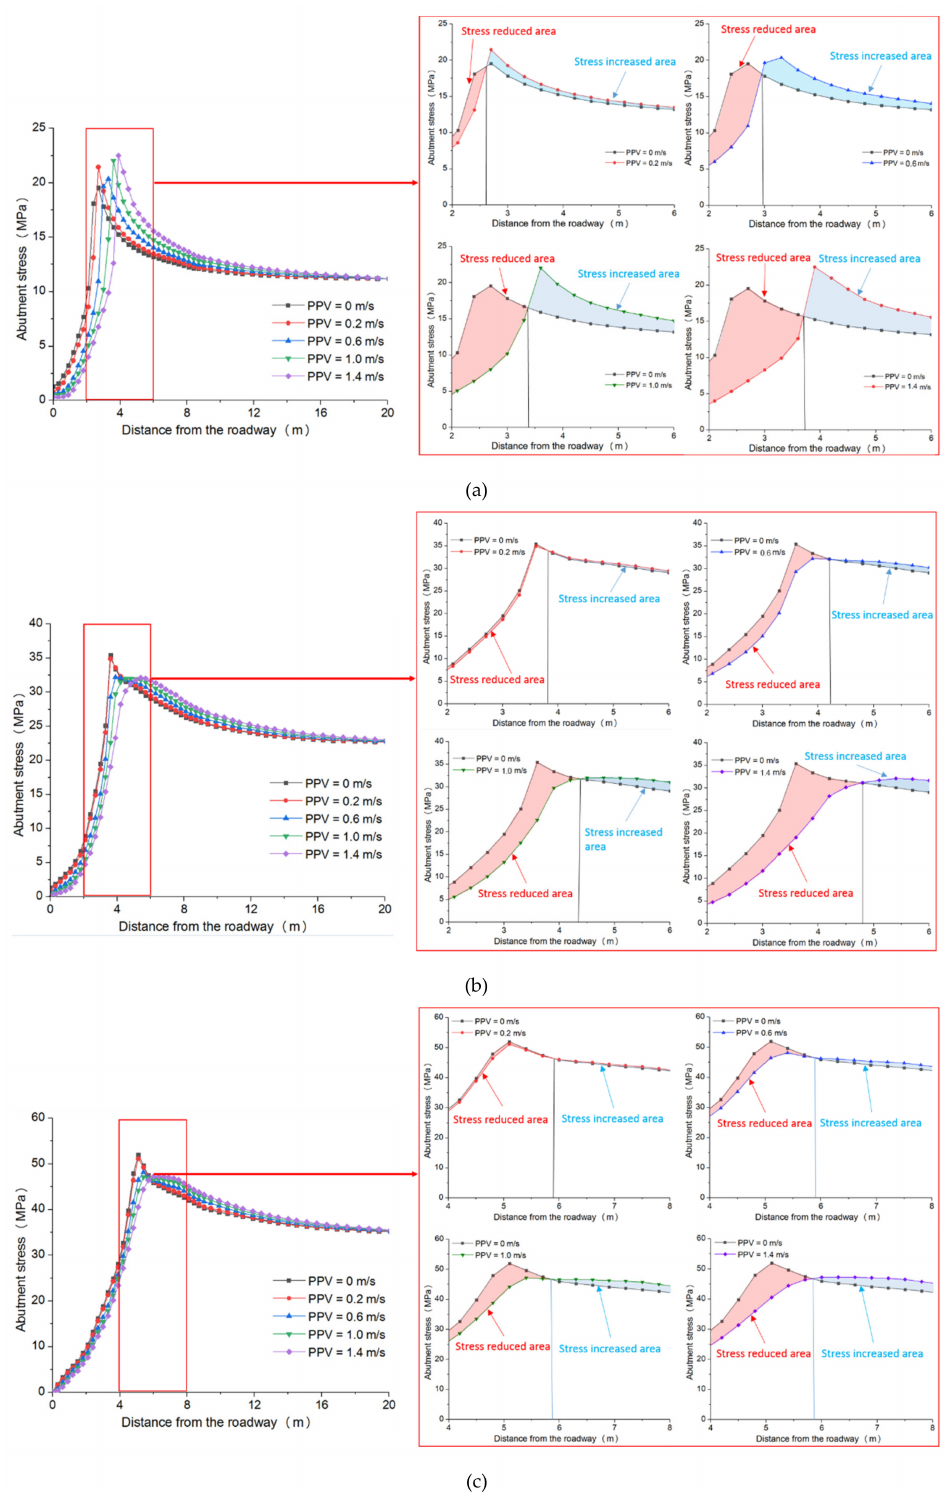
Figure 10. Variations of the roadway abutment stress under di ff erent superposed dynamic and static loads. ( a ) Variations of the roadway abutment stress when the roadway depth is 400 m, ( b ) Variations of the roadway abutment stress when the roadway depth is 800 m and ( c ) Variations of the roadway abutment stress when the roadway depth is 1200